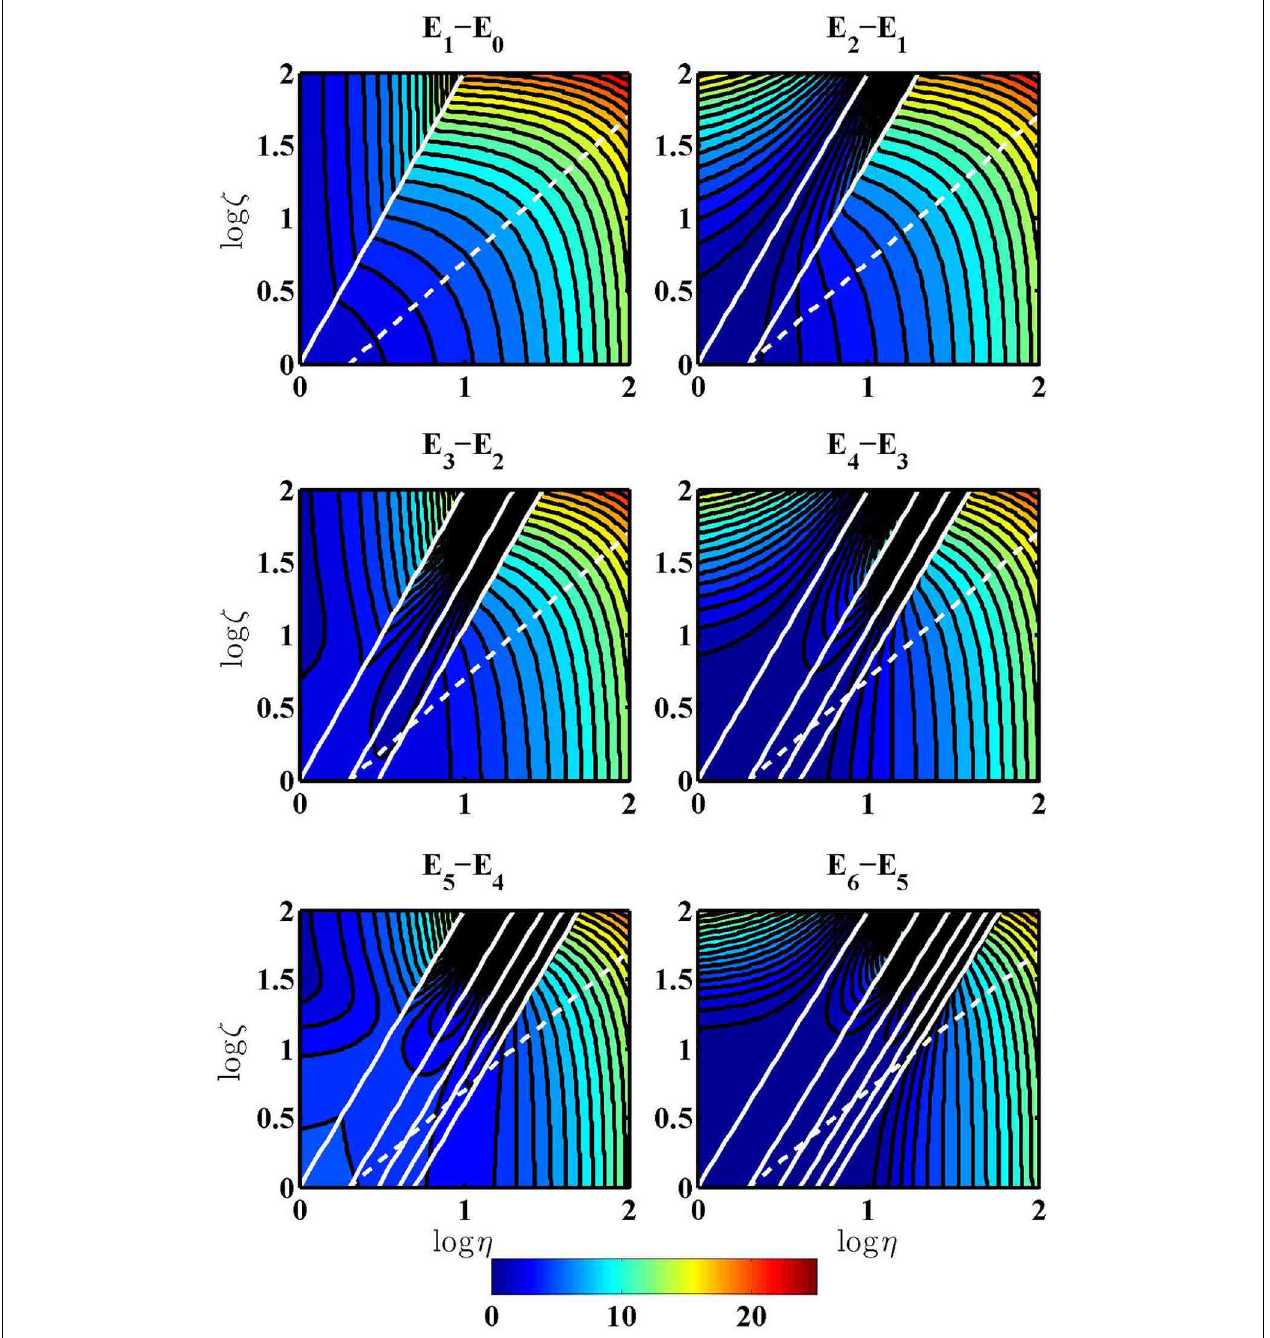
FIGURE 6 | Energy differences (gaps) between adjacent eigenenergy surfaces of Hamiltonian (Equation 1) for a planar quantum pendulum subject to combined fields. The energy gaps are shown as functions of the parameters η and ζ that characterize the strengths of, respectively, the